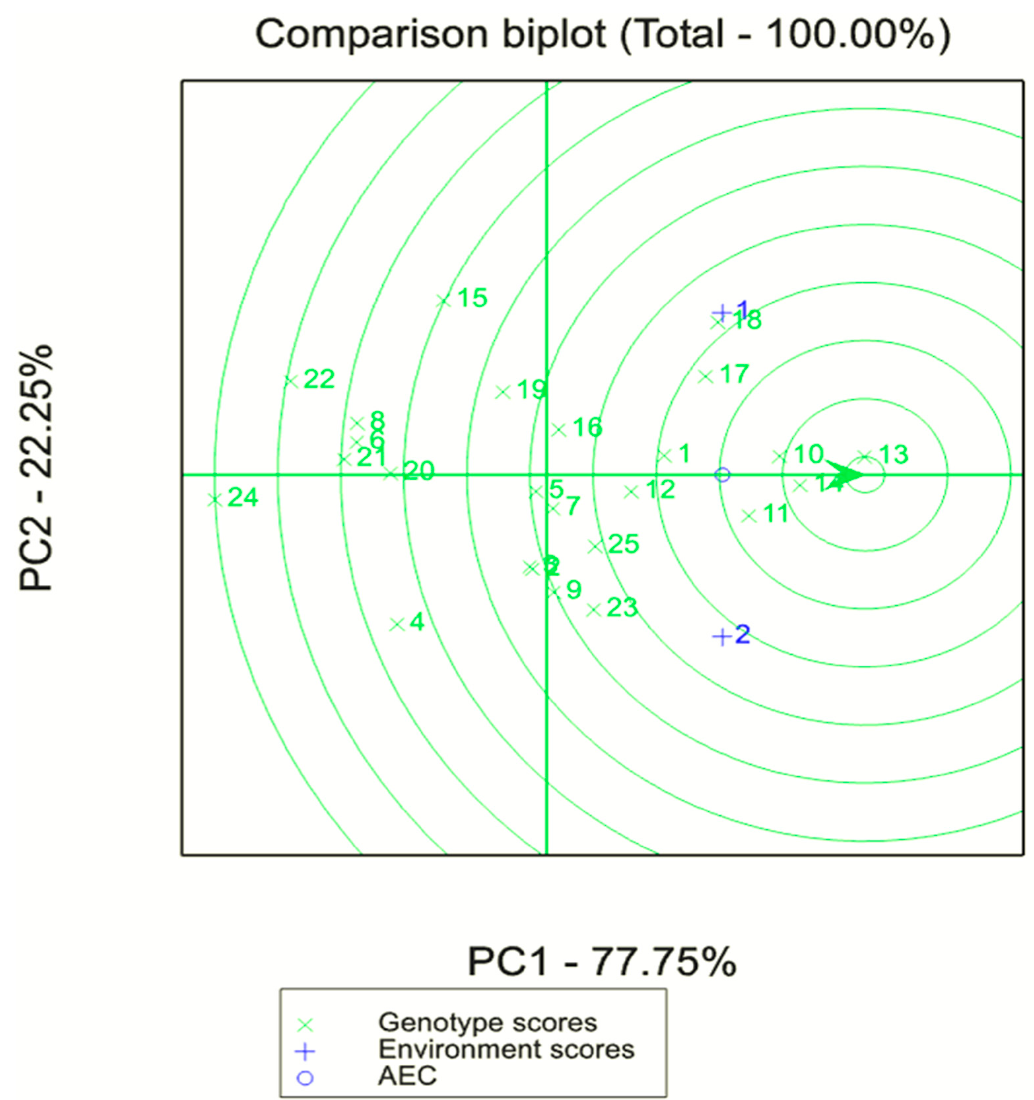
Figure 4. Genotype and genotype × environment (GGE) biplot analysis for total yield of the 23 tomato genotypes evaluated: green numbers correspond to genotypes (1 ‘Formula’ F 1 , 2–9 recombinant lines of ‘Formula’ F 1 , 10 ‘Elpida’ F 1 , 11–18 recombinant lines of ‘Elpida’ F 1 , 19 ‘Iron’ F 1 , 20–21 recombinant lines of ‘Iron’ F 1 , 22 ‘Sahara’ F 1 , 23–24 recombinant lines of ‘Sahara’ F 1 , and 25 ‘Makedonia’; and blue numbers refer to environments (one = high inputs and two = low inputs). AEC = Average Environment Coordination, PC = Principal Component.